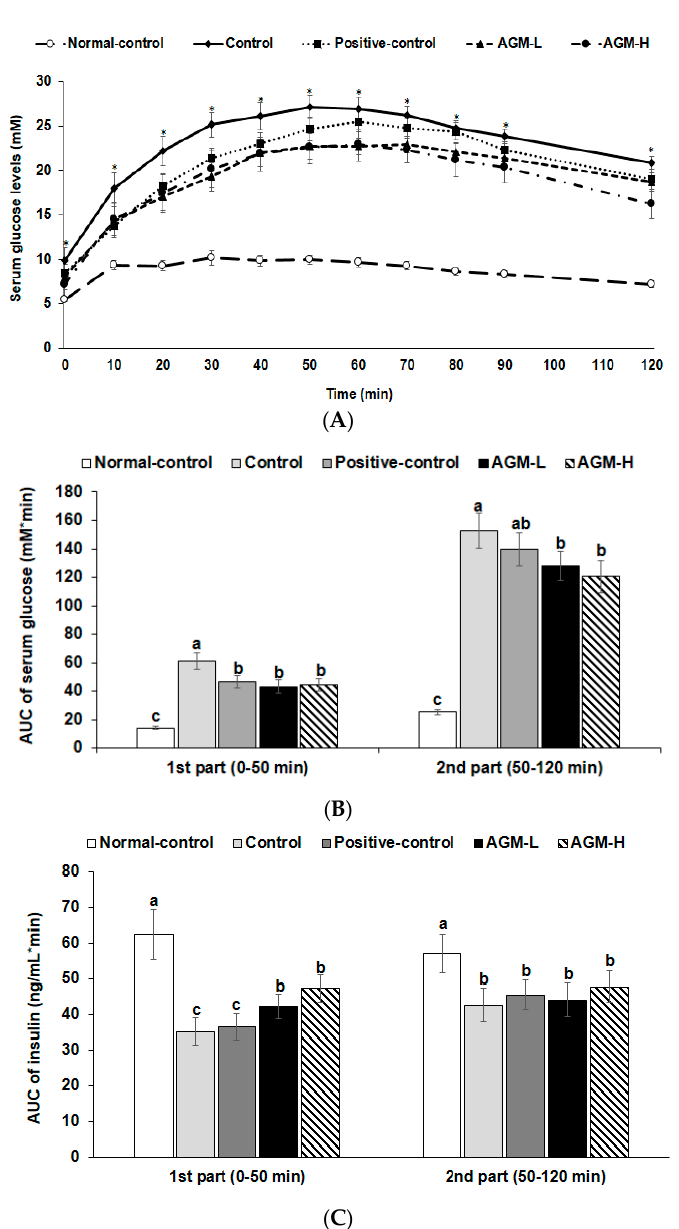
Figure 2. Serum glucose and insulin levels and area under the curve (AUC) of serum glucose and insulin during oral glucose tolerance test (OGTT). Px rats were fed a high fat diet supplemented with aronia, red ginseng, shiitake mushroom, and nattokinase powders (1) 0.5 g mixture/kg bw/day (AGM-L), (2) 1 g mixture/kg bw/day (AGM-H), (3) 1 g dextrin /kg bw/day (control), or (4) metformin (120 mg/kg body weight; positive-control) for 12 weeks. Sham rats fed the same diet of control. Changes of serum glucose levels ( A ) were measured after orally giving 2 g of glucose/kg body weight. The average of the area under the curve (AUC) of glucose ( B ) and insulin ( C ) during the first part (0–40 min) and second part (40–120 min) of OGTT. Each dot and bar and error bar represent the mean ± SD ( n = 10 of each group). * Significantly different among the groups at each time point at p < 0.05. a,b,c Different superscripts on the bars represent significant differences at S < 0.05.